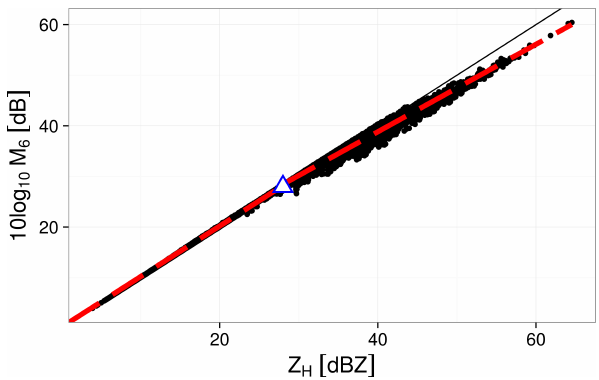
Figure 1. A sample of 20000 points from the training set, showing the relationship between radar reflectivity and DSD moment six in dB scale. The one-to-one line is shown in black; the red dashed line shows the fitted relationship of Eq. (13). The Z H threshold of 28dBZ is shown with a